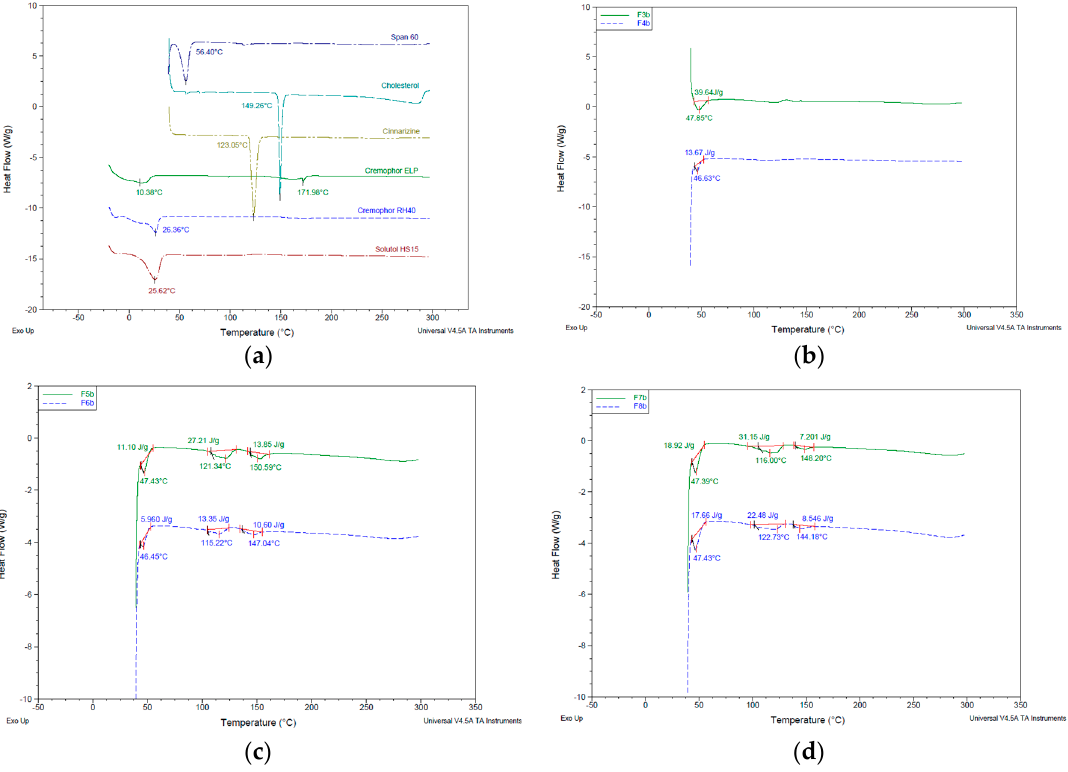
Figure 8. Differential Scanning Calorimetry (DSC) thermographs for ( a ) pure raw materials for niosomes formulation compositions; ( b ) freeze-dried formulations 3 and 4; ( c ) freeze-dried formulations 5 and 6; ( d ) freeze-dried formulations 7 and 8.